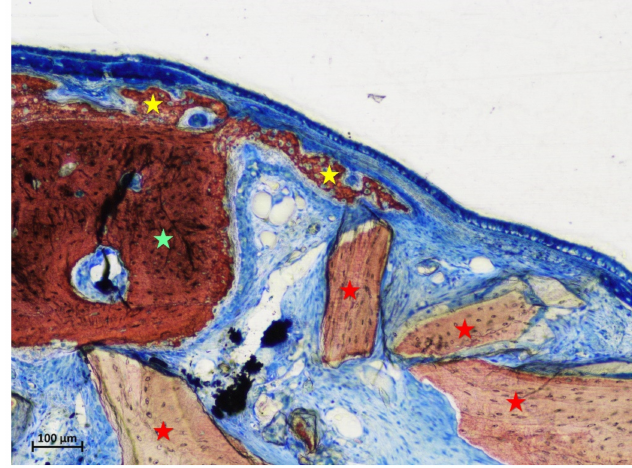
Figure 3. Photomicrograph of a ground section at the intermediate region of a test site after 2 weeks of healing. New bone was found always connected to the bone window. Stars indicate example of new bone (yellow) and xenograft granules (red). Stevenel’s blue and alizarin red stain.